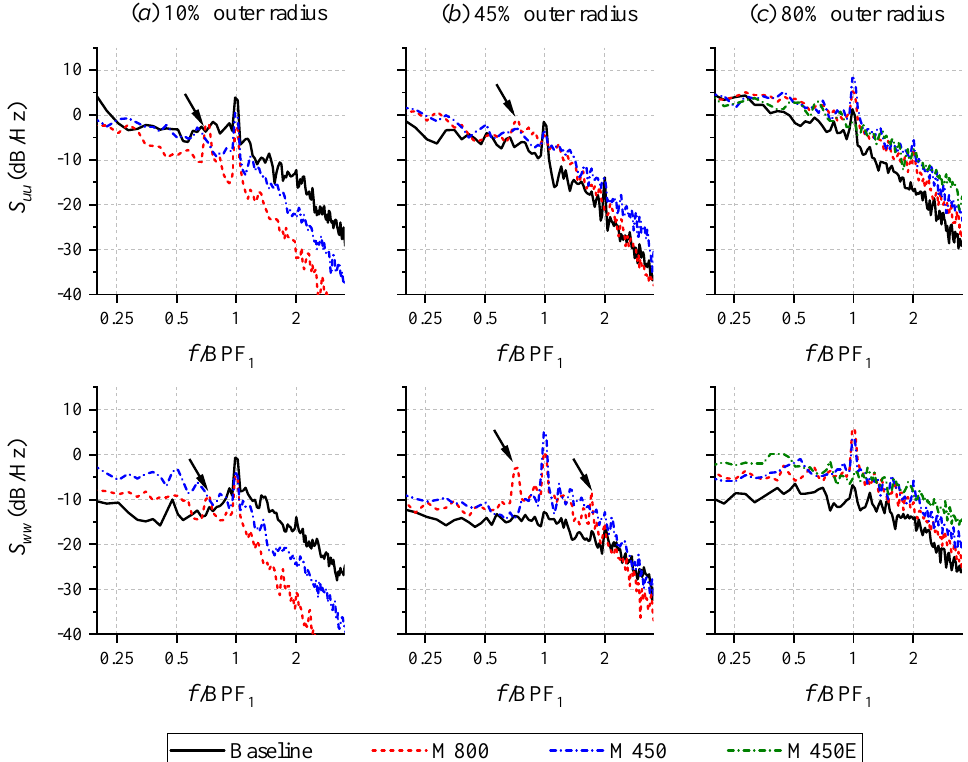
Figure 13. Plots of axial ( S uu ) and tangential ( S ww ) velocity fluctuations spectra at a height of 50mm (0.23 c ) above the OGV TE. The power spectral density is normalized against a reference velocity of 1m/s. The arrows in ( a , b ) indicate narrowband velocity fluctuations components that are unrelated to the